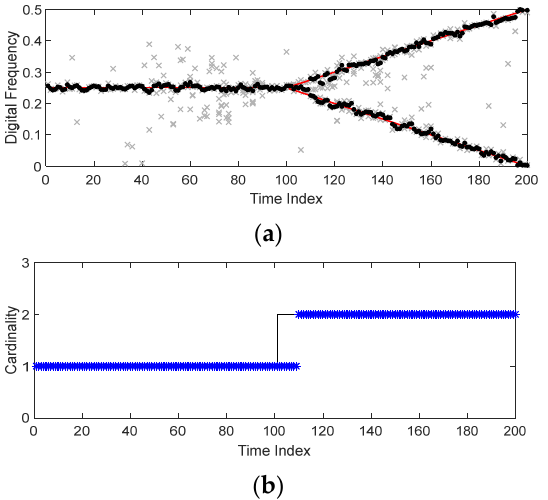
Figure 7. The result of the A_CPHD (case 1): ( a ) Frequency tracking; ( b ) Cardinality estimate.